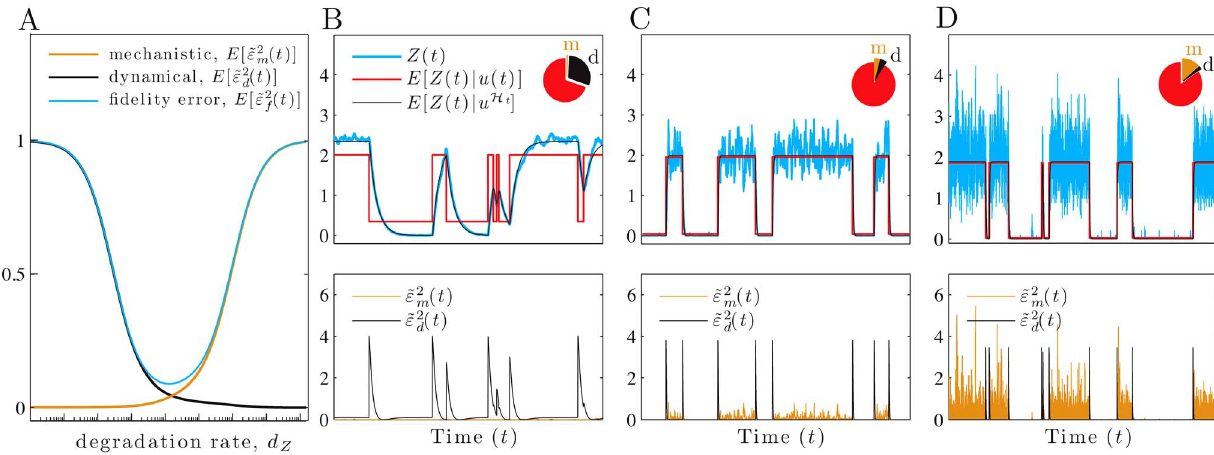
Figure 3. As the protein lifetime decreases, a trade-off between dynamical and mechanistic error determines fidelity. We consider a 2-stage model of gene expression with the input, u ( t ) , equal to the current rate of transcription, and the signal of interest s ( t ) ~ u ( t ) . (A) The magnitude of the relative fidelity errors as a function of the protein degradation rate, d Z (from Eqs. 11, 12 and 13), using a logarithmic axis. (B–D) Simulated data with u ( t ) as in Fig. 1A. The units for Z ( t ) are chosen so that its variance equals one in each case (hence Z ( t ) ~ ~ ZZ ( t ) and e : ( t ) ~ ~ ee : ( t ) ). Pie charts show the fractions of the protein variance due to the mechanistic (m) and dynamical (d) errors and to the transformed signal. The latter equals { 1 ~ d ~ 0 : 37 ) and fidelity is 2.2; in C, t ~ 0 : 02 ) and , is higher than optimal ( t Z ( t ) (cid:2) . In B, the relative protein lifetime, t Z 1 { E ½ ~ ee 2 u d Z u is optimal ( t Z u Z f u u ~ 0 : 003 ) and fidelity is 5.3. Dynamical error, e is lower than optimal ( t Z fidelity is 10.1; and in D, t Z d ( t ) , is the difference between E ½ Z ( t ) D u H t (cid:2) (black) u u and the faithfully transformed signal E ½ Z ( t ) D u ( t ) (cid:2) (red), and decreases from B to D, while mechanistic error increases. The lower row shows the magnitudes of the relative dynamical error (black) and relative mechanistic error (orange). All rate parameters are as in Fig. 1 A&C with d M ~ 0 : 013 s { 1 , unless otherwise stated.